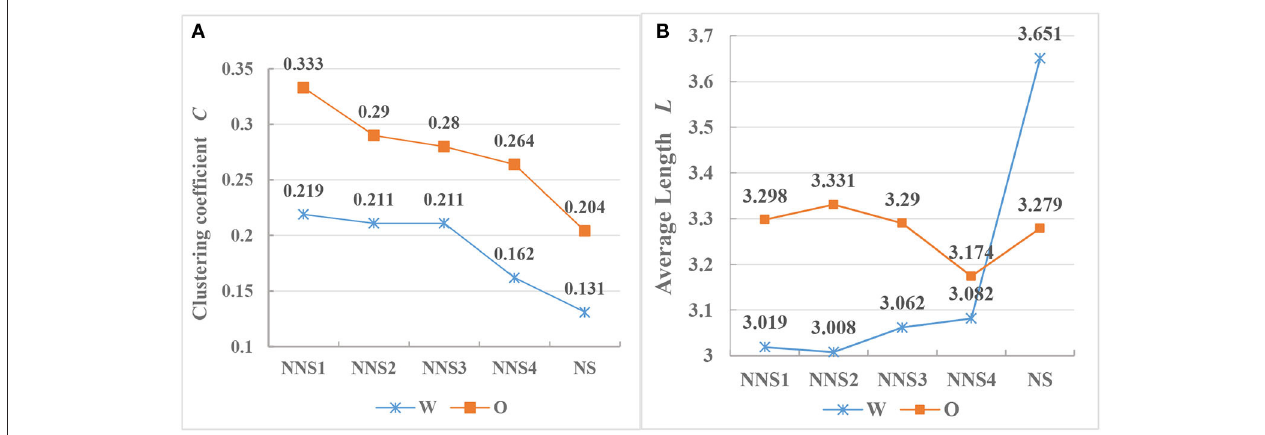
FIGURE 6 | This is a figure with sub figures, (A) shows the values of C in CSL learners’ and Chinese native speakers’ syntax networks, (B) displays the values of L in CSL learners’ and Chinese native speakers’ syntax